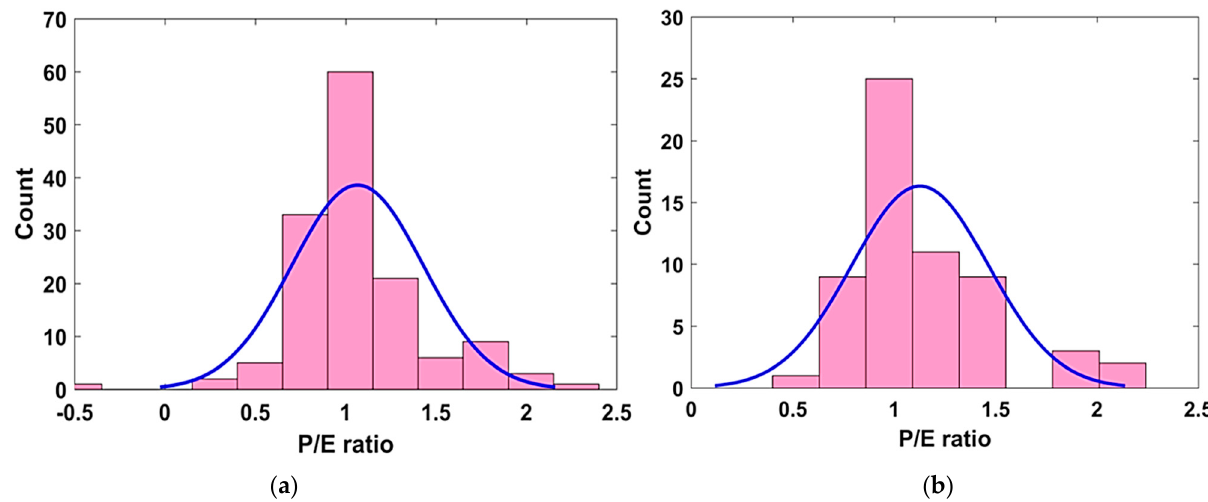
Figure 8. P/E ratio distribution of best performing model T3. ( a ) TR phase, ( b ) TS phase.